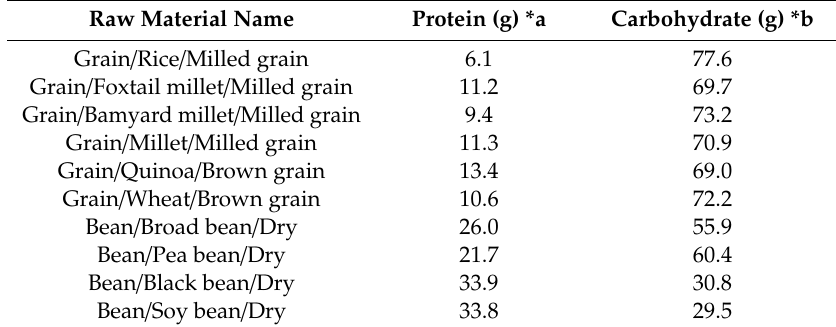
Table 2. Protein and carbohydrate content in raw materials (from the Japanese Standard Tables of Food Composition in Japan 2015).